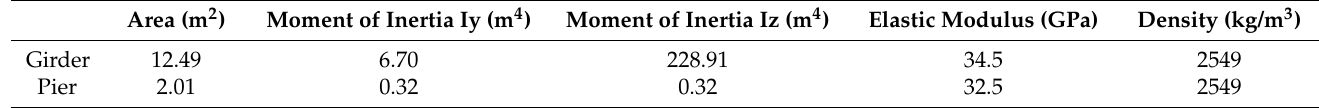
Table 1. Basic parameters of the bridge structure.